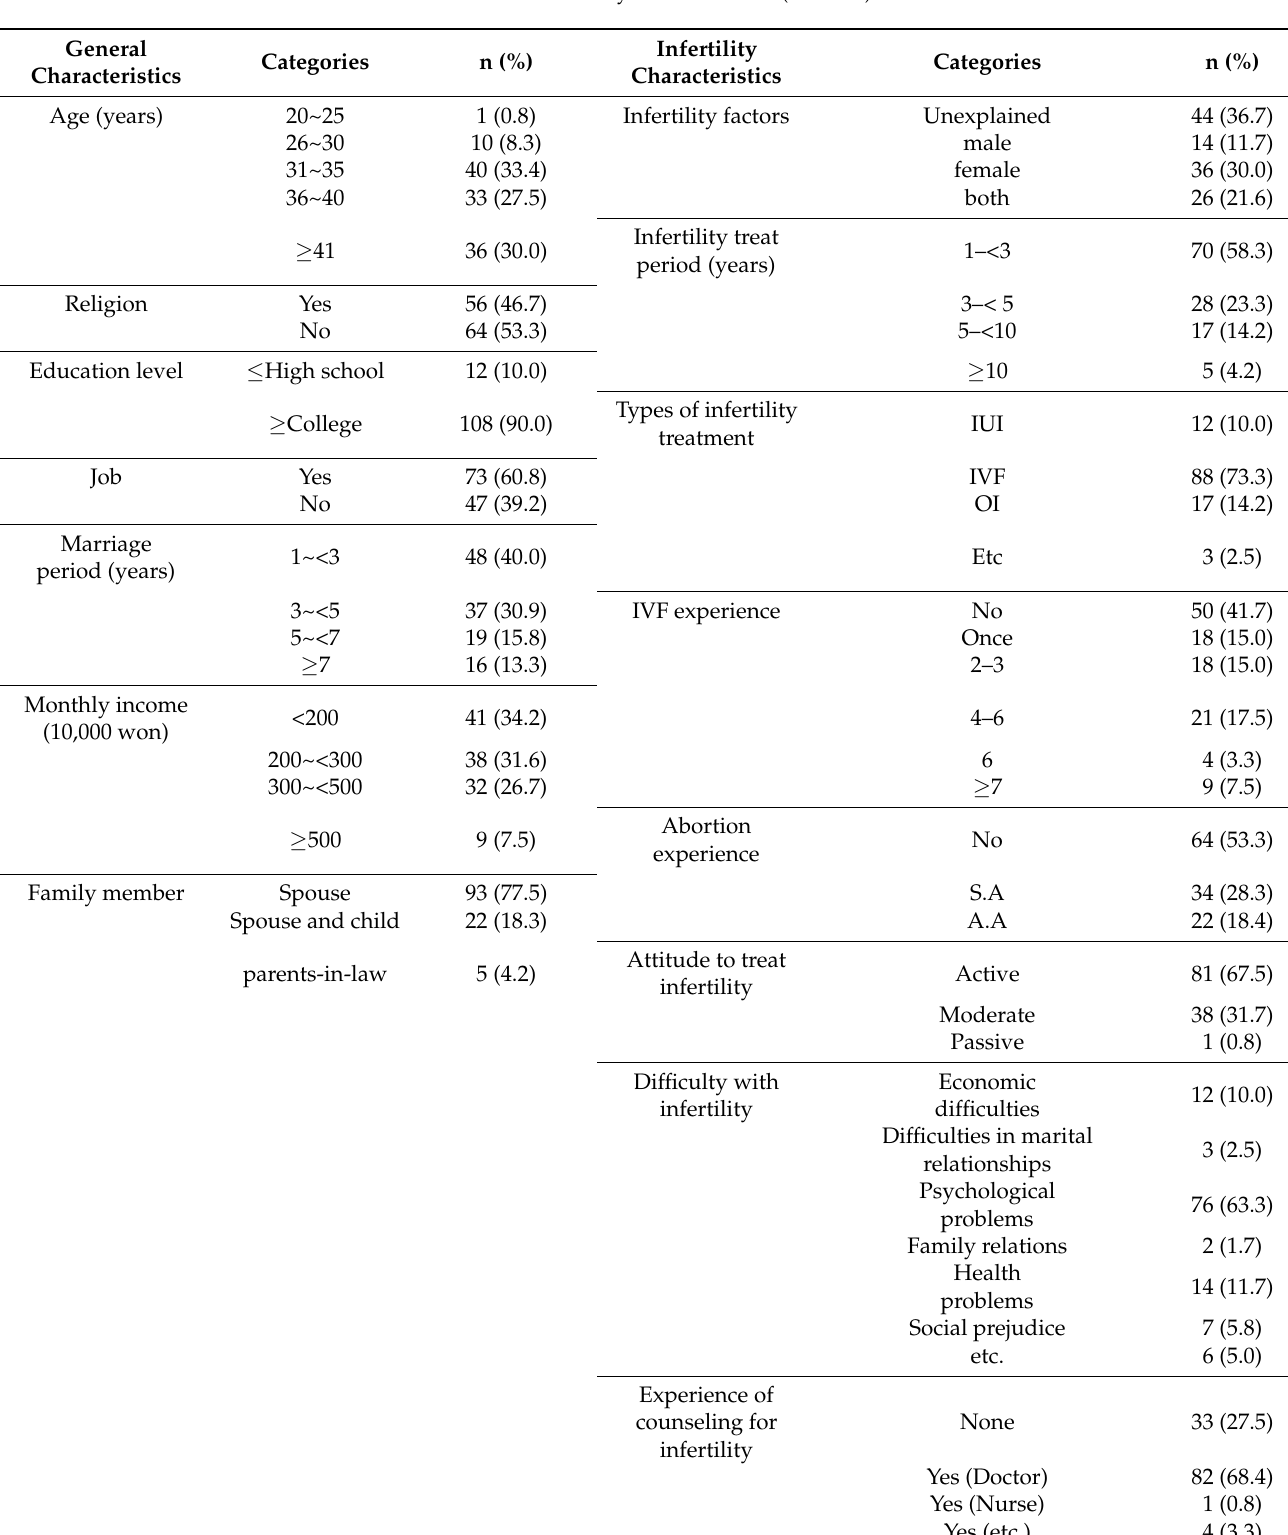
Table 1. General and infertility characteristics ( N =